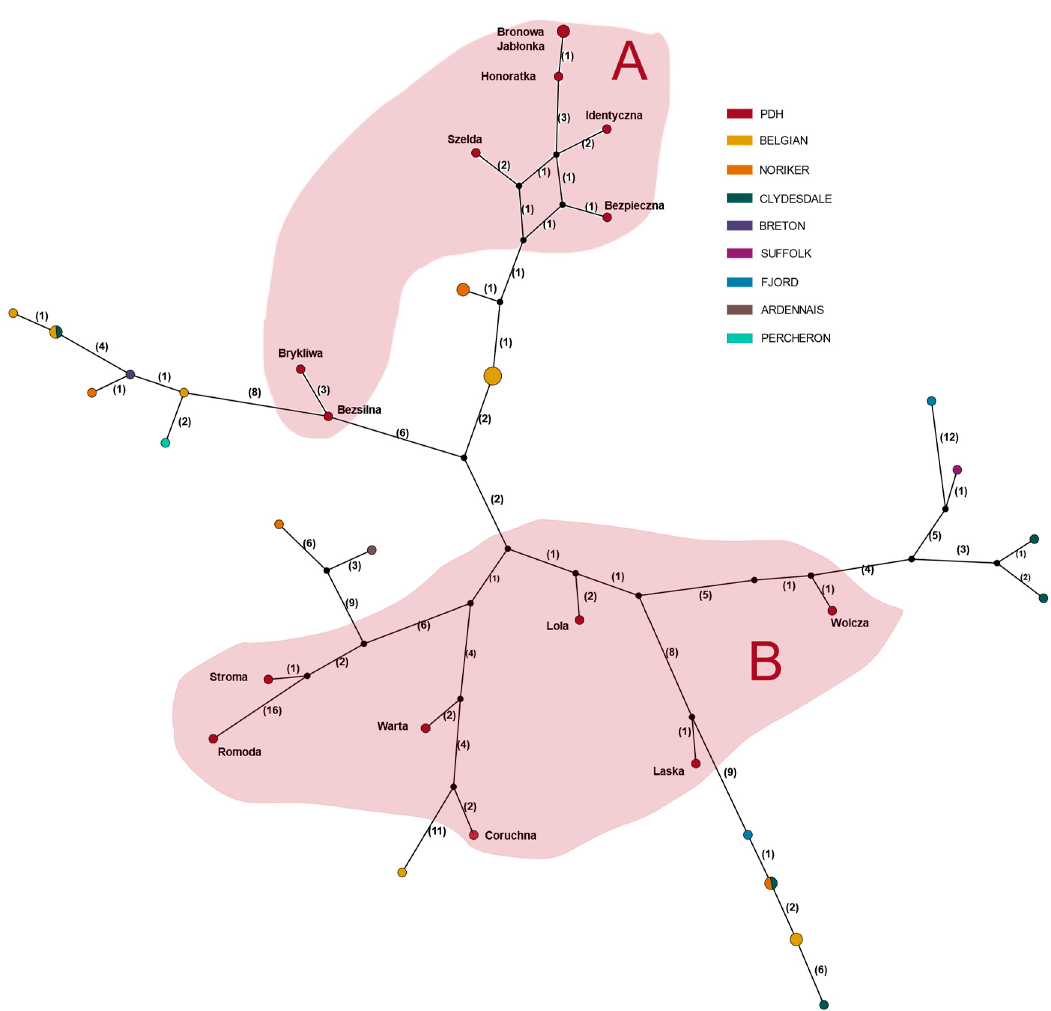
Figure 2. A median-joining network of the modern breeds haplotypes ( n = 41). Each breed is represented by a different color. Haplotypes that are separated by only one segregating side are clustered together. The size of the circles represents the number of haplotypes that clustered together. Sizes of the nodes are proportional to the numbers of parsimony-informative sites defining the haplotypes, which are given in the numbers in parentheses. Haplogroups of Polish draft horse are marked with the corresponding color.